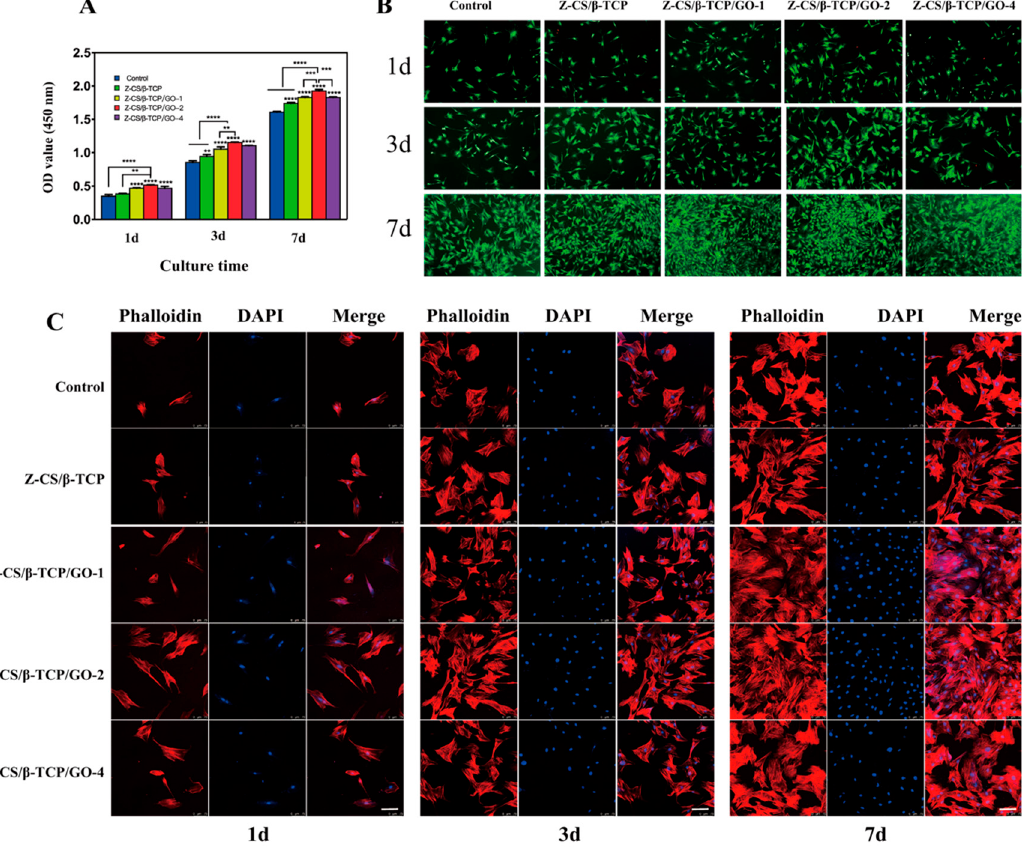
Figure 3. Proliferation, viability, and morphology of cells cultured with different scaffolds for one, three, and seven days. ( A ) CCK-8 assay (** p < 0.01, *** p < 0.001, and **** p < 0.0001). ( B ) Live/dead staining: green (live), red (dead), Scale bars, 100 µ m. ( C ) Fluorescent images of rBMSCS morphologies: blue (nucleus), red (cytoskeleton), Scale bars, 300 µ